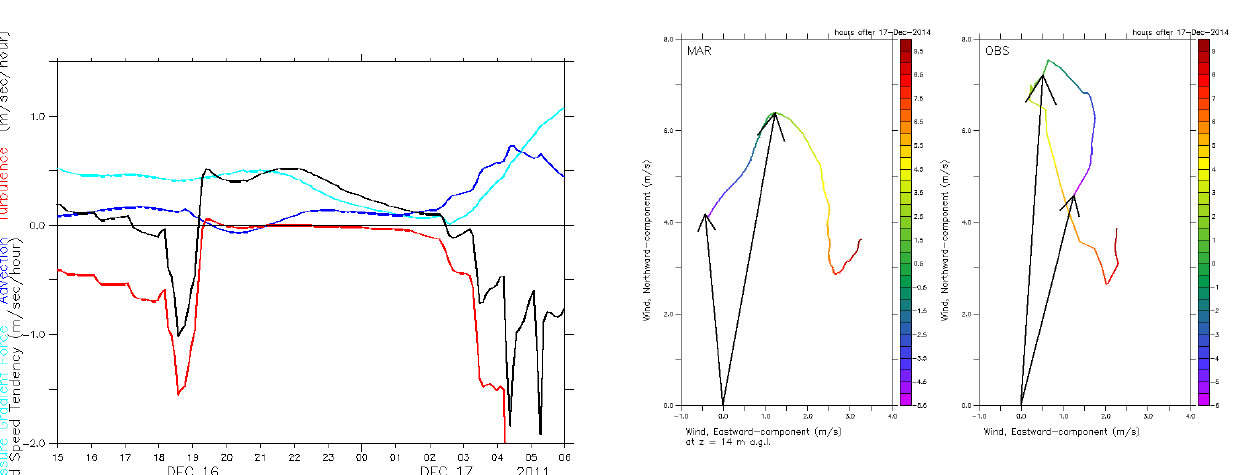
Figure 10. Wind hodograph at Dome C between 16 December 2011 19:00LT and 17 December 2011 10:00LT. Colours represent time in hours before/after 17 December midnight (negative/positive val- ues). Arrows are plotted for 16 December 2011 19:00LT and 17 December 2011 01:30LT. Panel labeled “MAR”: simulation at z = 14ma . g . l . Panel labeled “OBS”: observations at level 3 of the tower ( z = 17.9ma . g . l .